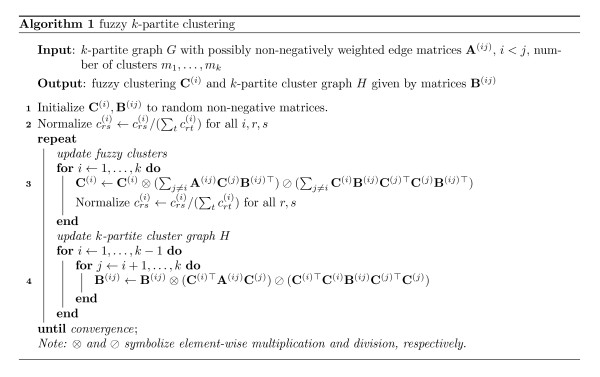
Fuzzy clustering algorithm. Summarization of the final fuzzy k-partite clustering algorithm.